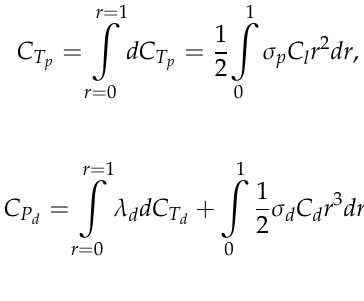
Figure 5. Schematic diagram of speed and pressure before and after the disc.